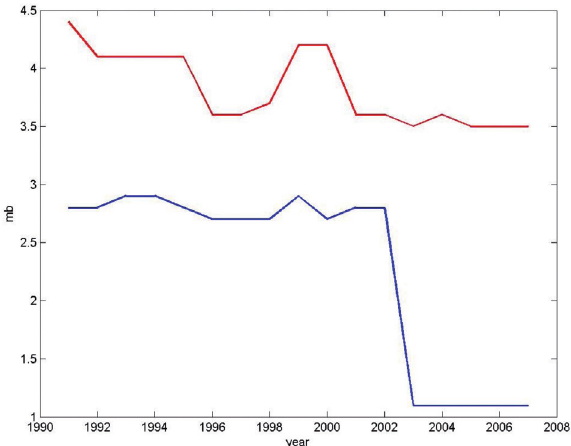
Figure 4. Changing of values of minimum (blue) and representative (red) magnitudes in the ISC catalogue for Central Asia territory.